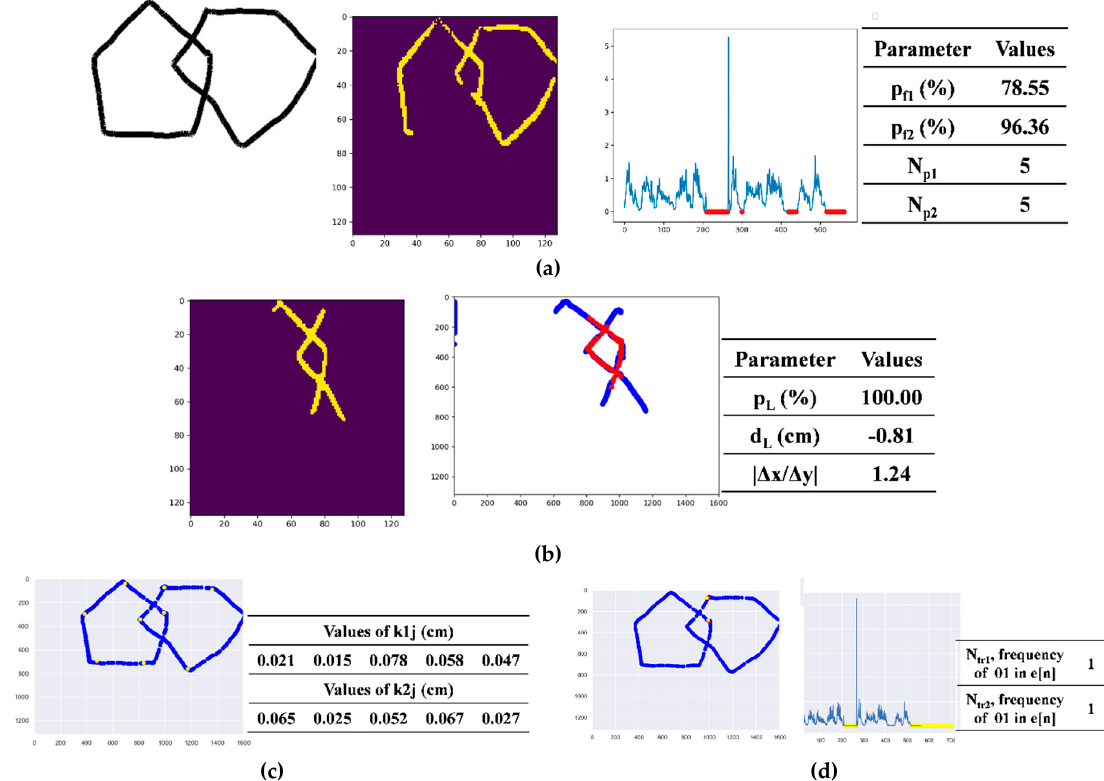
Figure A1. A case of a left-handed male subject (27 years old): ( a ) the original drawing (left) along with the segmented image (middle left) produced by the pre-trained model, Deep5, the corresponding velocity graph (middle right), the corresponding parameter values (right); ( b ) the segmented images generated and analyzed by the pre-trained model, DeepLock (left and middle) and the corresponding parameter values (right); ( c ) the clusters marked on the original drawing (left) and the corresponding parameter values (right); and ( d ) the up and down points marked on the original drawing (left) as well as on the velocity graph (middle) and the corresponding parameter values (right).